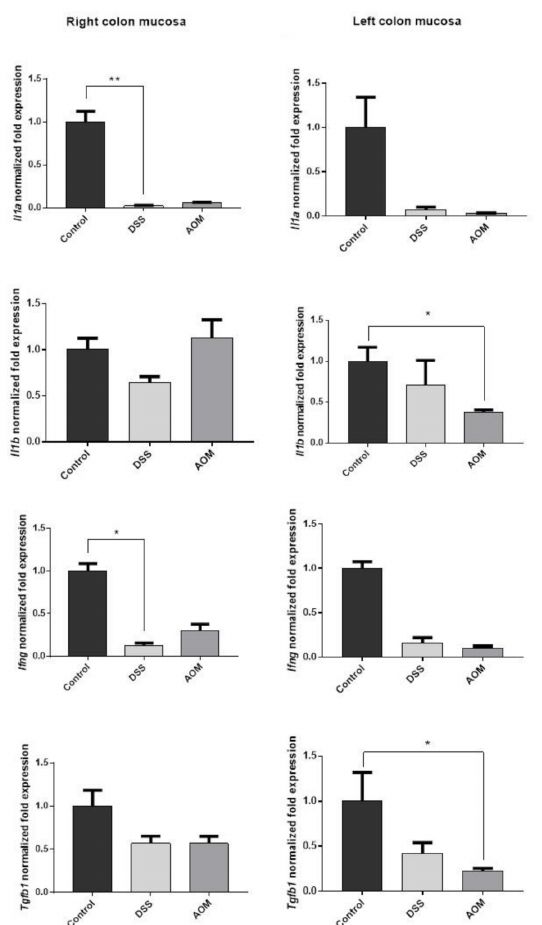
Figure 7. The expression of cytokines in the full colon mucosa of DSS- or AOM-induced rats at 1 month after the end of treatments. The expression of all measured genes in the induced rats, either after DSS or AOM, was reduced in comparison with control rats. The downregulation was present in all colons with exception of Il1b in the right colon, remaining at the control levels. Significant differences were found, particularly after AOM treatment in both left and right colon mucosa. Gene expression was evaluated according to expression of housekeeping gene Ppia . The expression stability of reference gene Ppia was confirmed using Normfinder, Bestkeeper, and RefFinder algorithms. Data were normalised to control groups. Significance by Kruskal–Wallis test: * for p < 0.05 and ** for p <